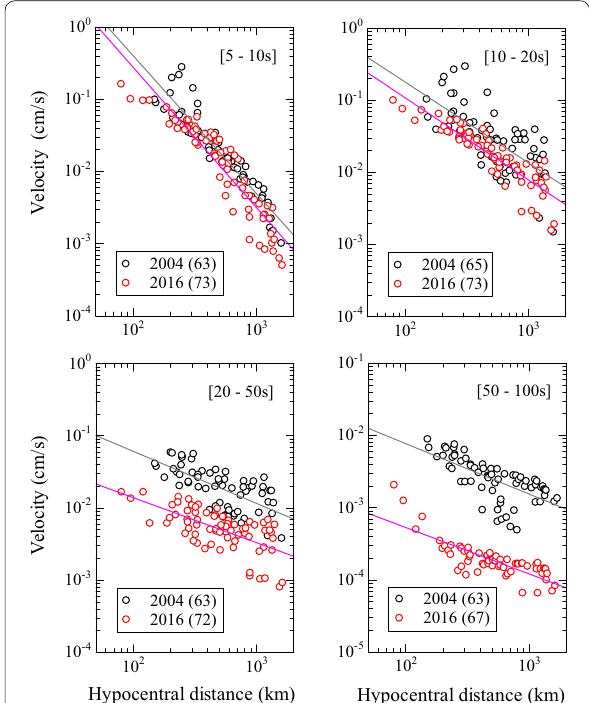
Fig. 14 Standard deviations as a function of period and distance for the 2004 Mw 6.5 and 2016 Mw 5.8 events. The black line with circles and red line with diagonal crosses denote the standard deviations on a base-10 log-scale with respect to the GMPEs in Morikawa and Fujiwara (2013) and Dhakal et al. (2015), respectively. a 2004 event for distances between 100 and 200 km. b 2004 event for distances larger than 200 km. c 2016 event for distances between 100 and 200 km.